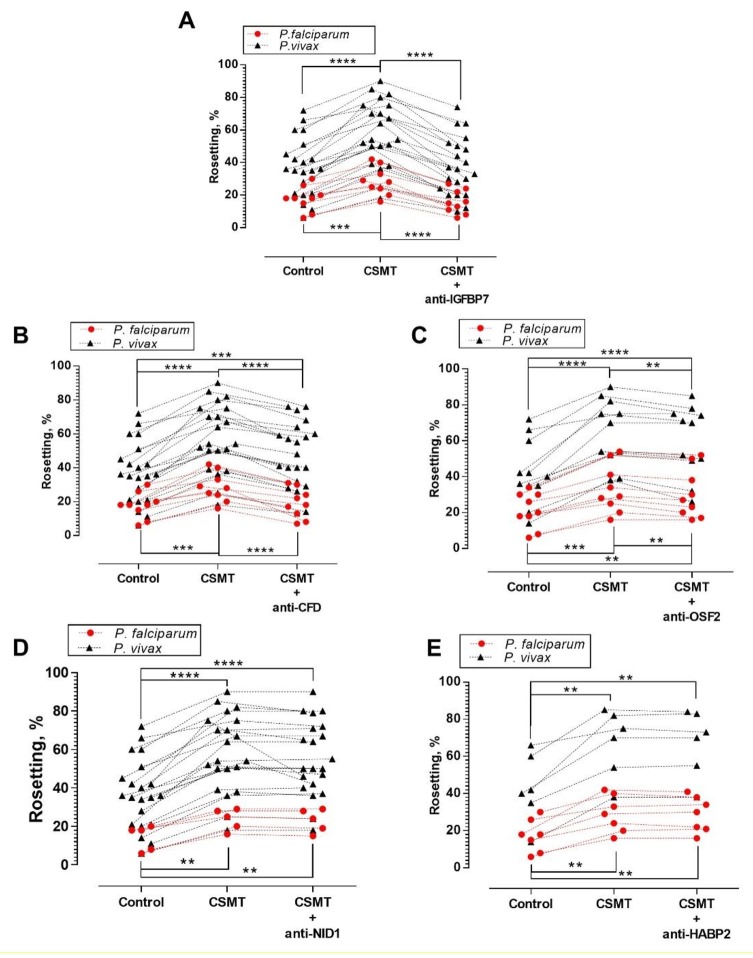
Antibody blocking assay.One-way ANOVA with Tukey’s test was conducted to compare the rosetting rates between the control, CSMT and CSMT + antibodies against proteins of interest. (A) Rosetting rates were significantly increased by CSMT [Pf (n = 9): p=0.0008; Pv (n = 21): p<0.0001]. Anti-IGFBP7 significantly reduced the CSMT-mediated rosette-stimulation [Pf: p<0.0001; Pv: p<0.0001]. No significant difference was found between the control and CSMT + anti-IGFBP7 groups [Pf: p=0.5498; Pv: p=0.8724]. (B) Significant rosette-stimulation was found between control and CSMT [Pf (n = 9): p=0.0008; Pv (n = 21): p<0.0001]. Anti-CFD significantly reduced CSMT-mediated rosette-stimulation [Pf: p=0.0003; Pv: p<0.0001]. A significant difference was detected between control and CSMT + anti-CFD groups for Pv (p=0.0002), but not in Pf (p=0.8494). (C) Rosetting rates were significantly increased by CSMT [Pf (n = 9): p=0.0004; Pv (n = 11): p<0.0001]. Anti-OSF2 significantly reduced the CSMT-mediated rosette-stimulation [Pf: p=0.0017; Pv: p=0.0038]. A significant difference was detected between control and CSMT + anti-OSF2 groups for Pf (p=0.0058) and Pv (p<0.0001). (D) Rosetting rates were significantly increased by CSMT [Pf (n = 5): p=0.0038; Pv (n = 21): p<0.0001]. Anti-NID1 did not significantly alter CSMT-mediated rosette-stimulation [Pf: p=0.1432; Pv: p=0.1369]. A significant difference was found between control and CSMT + anti-NID1[Pf: p=0.0051; Pv: p<0.0001]. (E) Rosetting rates were significantly increased by CSMT [Pf (n = 7): p=0.0040; Pv (n = 6): p=0.0051]. Anti-HABP2 did not significantly alter CSMT-mediated rosette-stimulation [Pf: p=0.8514; Pv: p=0.9358]. A significant difference was found between control and CSMT + anti-HABP2 [Pf: p=0.0045; Pv: p=0.0073]. Of note, anti-human NID1 IgG was of the same subclass and raised in the same animal species as the antibodies used against IGFBP7, CFD, and OSF2 (Supplementary file 1). Hence, it also acted as a negative control in this set of experiments .* p<0.05, **p<0.01, ***p<0.001, ****p<0.0001.